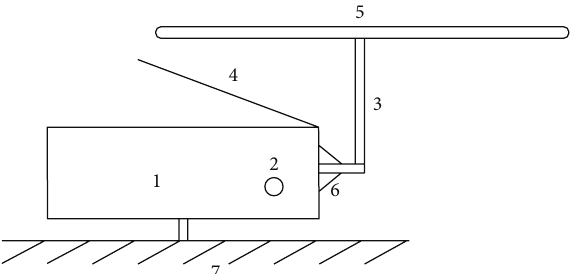
Figure 1: The scheme of the automatic device for deposited precipitation measurement (1: case with electronics, 2: connector, 3: holder, 4: thermal cover, 5: collecting board, 6: gasket cover, and 7: